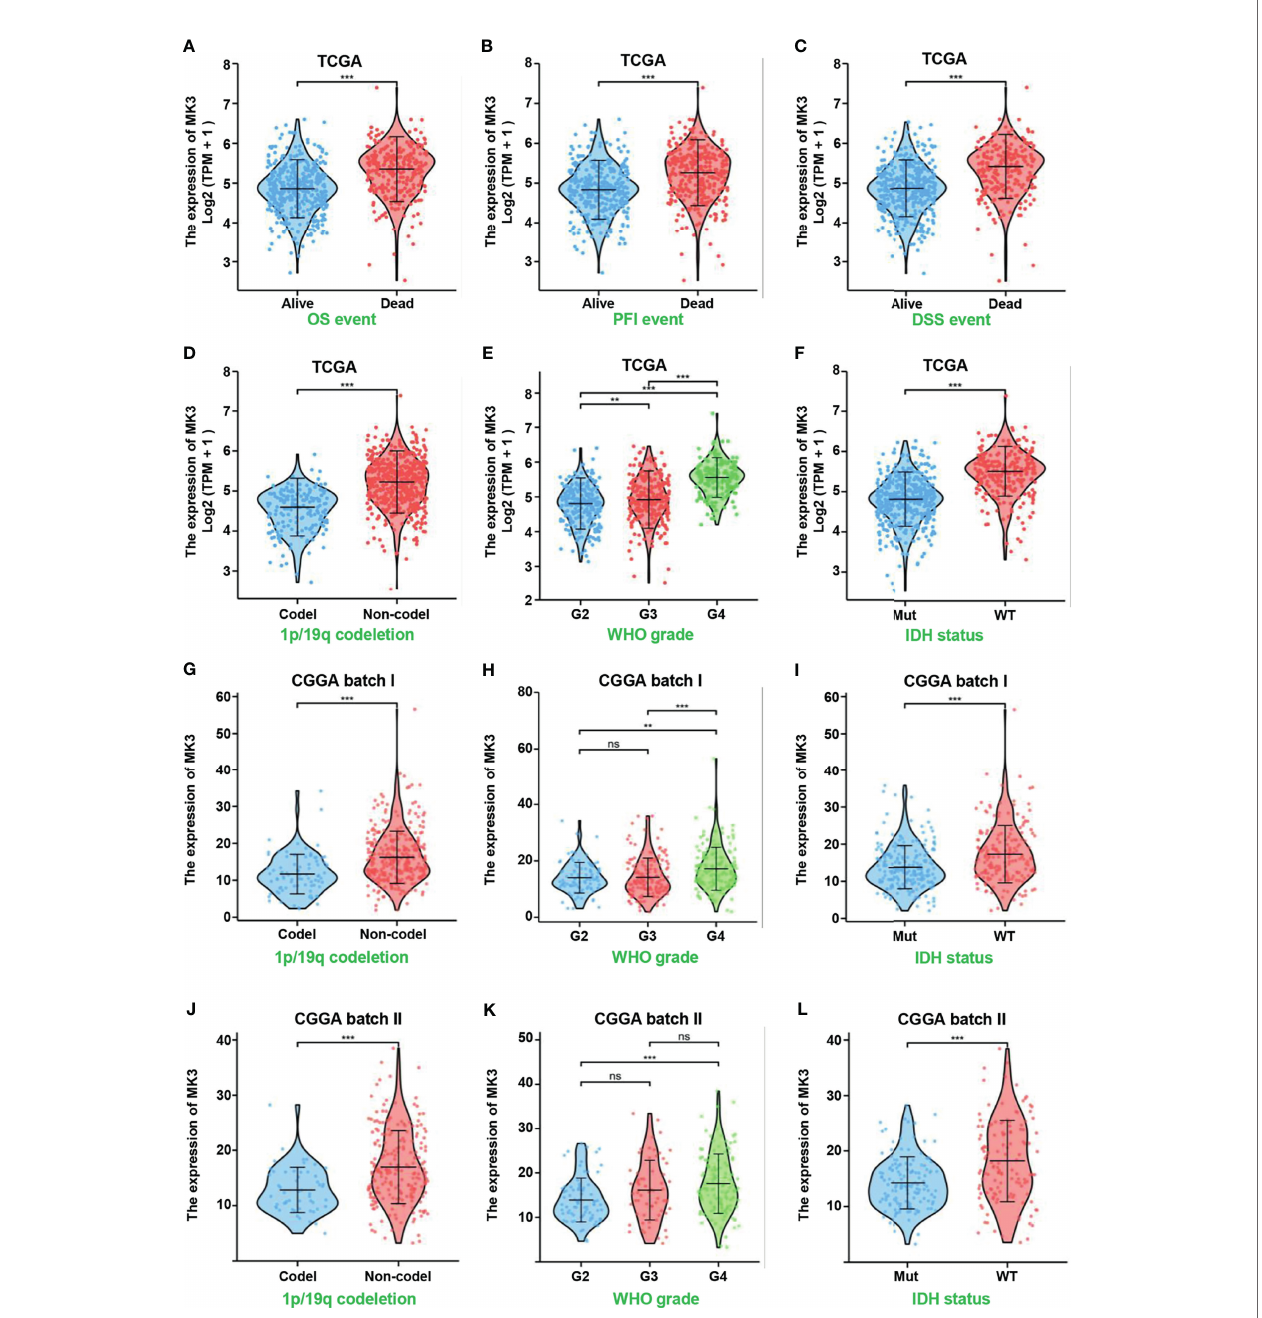
FIGURE 2 | Overexpressed MK3 was associated with poor clinicopathologic features of glioma. (A – C) MK3 expression in OS (A) , PFI (B) , and DSS (C) events of human glioma samples in TCGA database. (D – F) Comparison of MK3 expression in different groups of 1p/19q codeletion (D) , WHO grade (E) , and IDH status (F) of human glioma samples in TCGA database. (G – L) Comparison of MK3 expression in different groups of 1p/19q codeletion (G, J) , WHO grade (H, K) , and IDH status (I, L) of human glioma samples in CGGA database. OS, overall survival; PFI, progression-free interval; DSS, disease-speci fi c survival; TCGA, The Cancer Genome Atlas; CGGA, Chinese Glioma Genome Atlas. ns, no signi fi cance, **p < 0.01 and ***p <